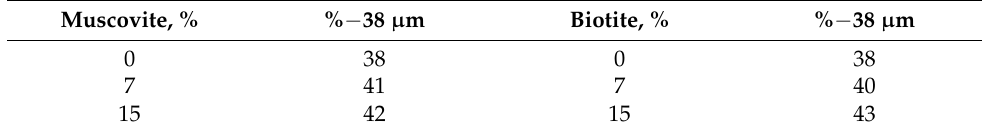
Table 2. Percentage of particles in the − 38 micrometers size fraction of the flotation